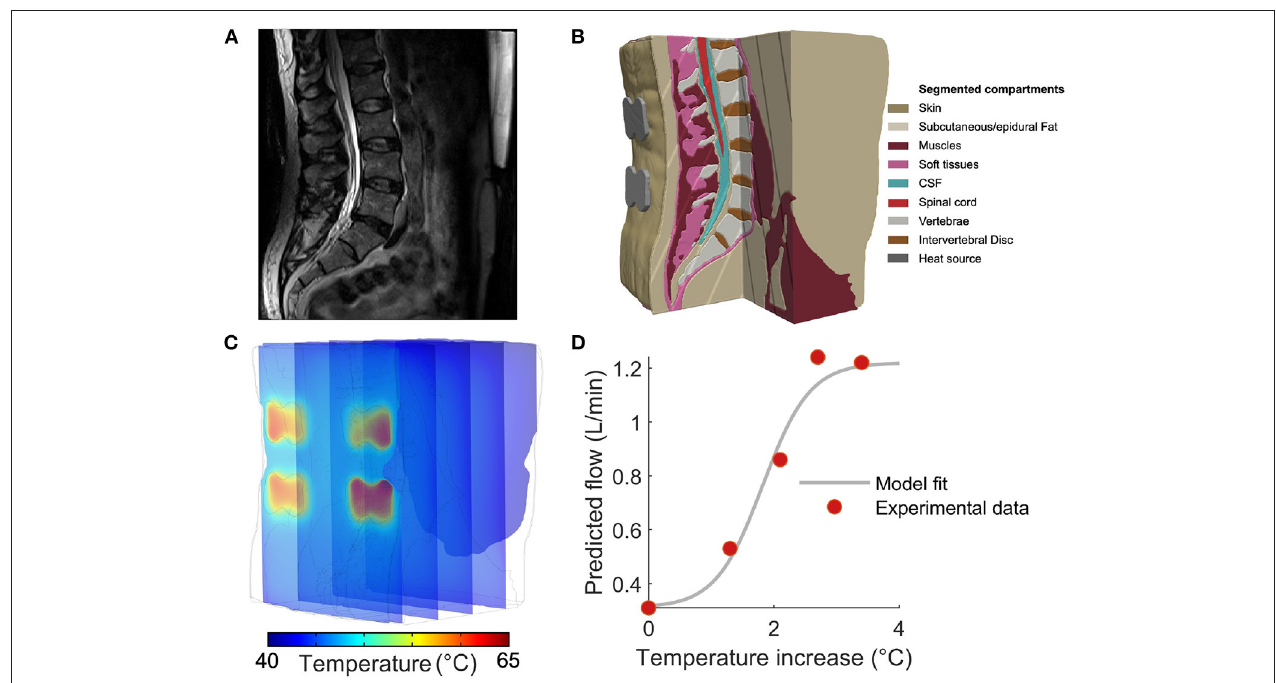
FIGURE 1 | Constructing a computational model to predict tissue temperature and blood flow during thermal massage. (A) Sagittal slice of a T2-weighted anatomical MRI used to construct the computational model developed in this study. (B) Based on image contrast, the volume was segmented into nine tissues that were then endowed with physical properties governing the physiological response to an external heat source. (C) The Pennes bio-heat equation was solved with a finite element model (FEM) solver, yielding the temperature during thermal massage throughout the volume. The locations of the four actuators are apparent from the temperature “hot-spots” in the superficial slice. (D) In order to translate model derived tissue temperature to the predicted changes in blood flow, we constructed an empirically-guided sigmoidal model that outputs the expected blood flow based on in situ tissue temperature. Red markers indicate the measurements performed by Chiesa et al., while the gray curve denotes the resulting model